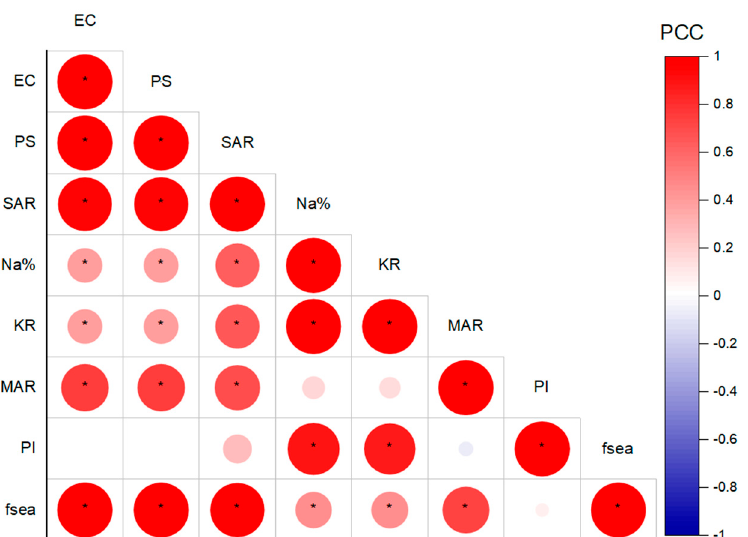
Figure 10. Correlation map of the SWI index ( f sea ) and irrigation hazard indices (EC, PS, SAR, Na%, KR, MAR, and PI) (CC is the Pearson correlation coe ffi cient).